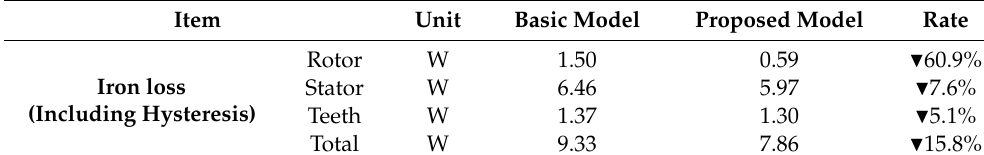
Table 9. Comparison of iron loss by part.